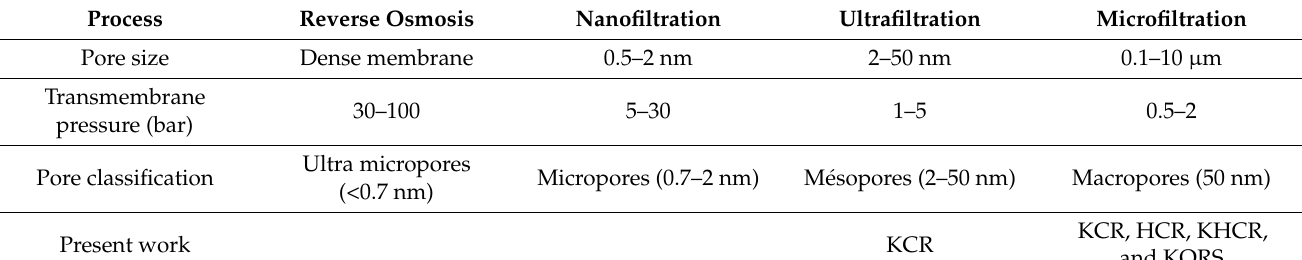
Table 3. Characteristics of different ceramic filters from the literature ([2,4,10,22,58,64,65]), in compar- ison to those of the clay ceramics from this